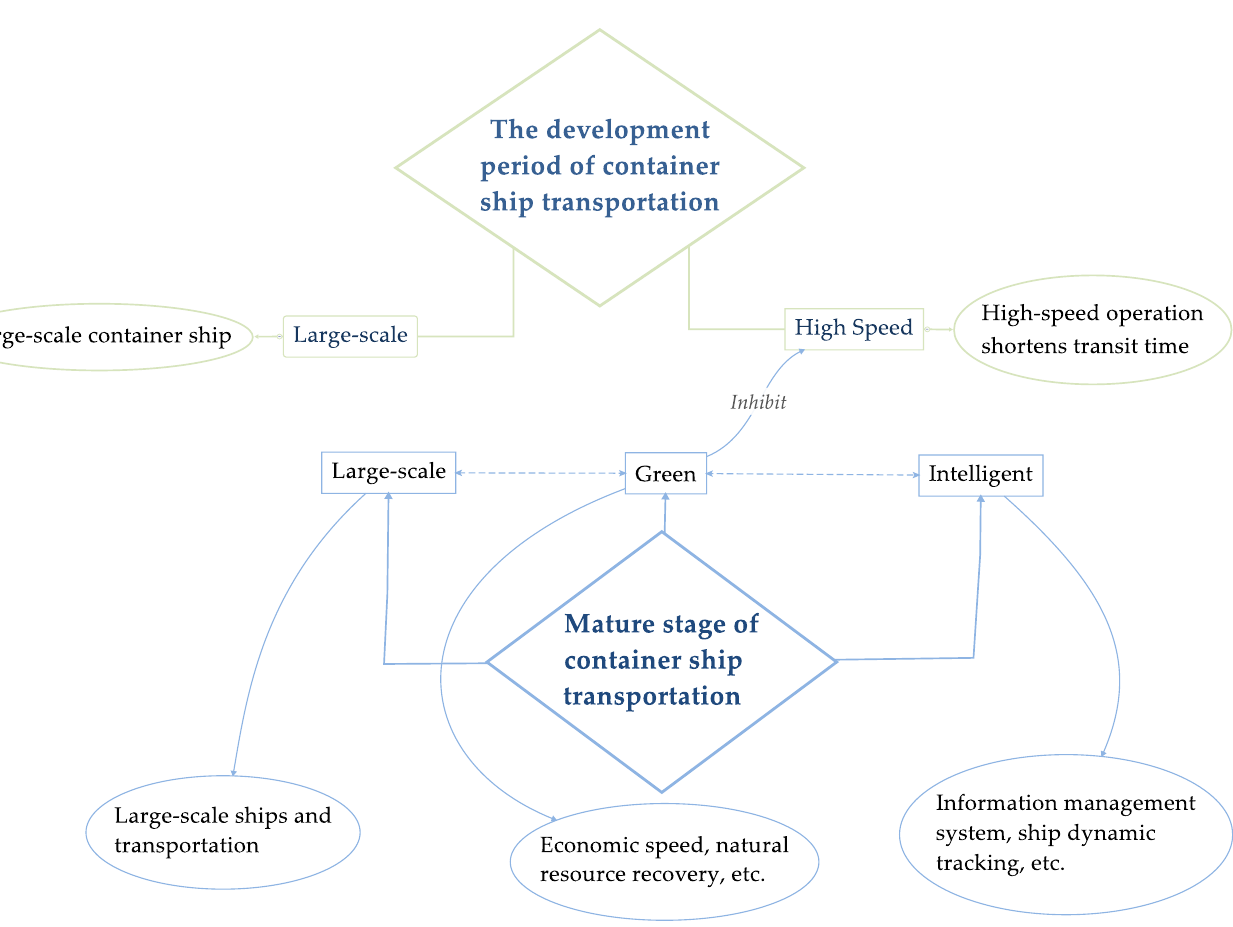
Figure 16. Changes in the development trend of container ships.